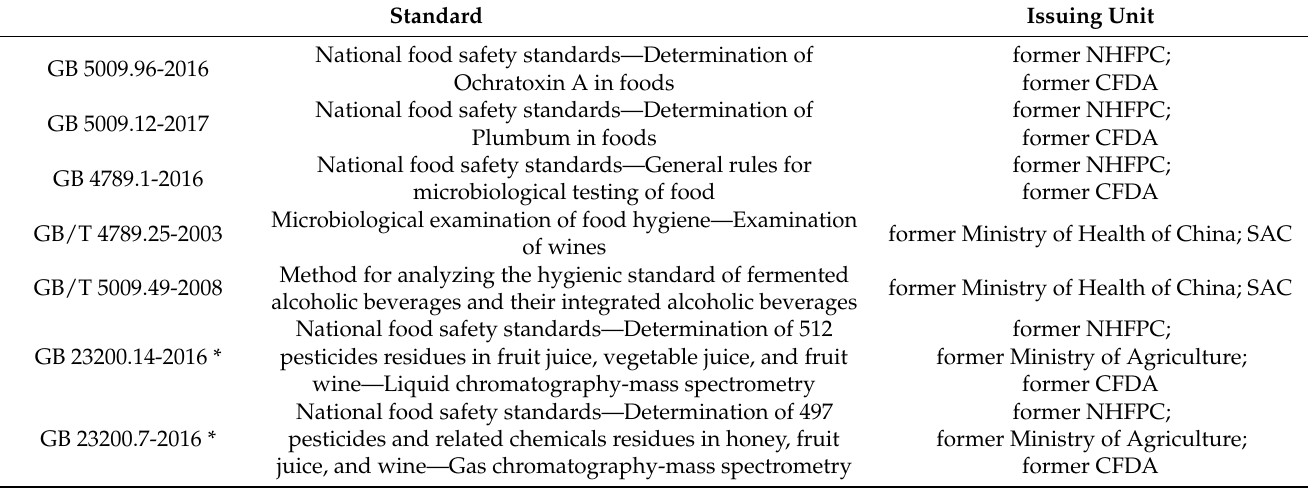
Table 4. National standards for testing methods of hygienic indicators of wine in